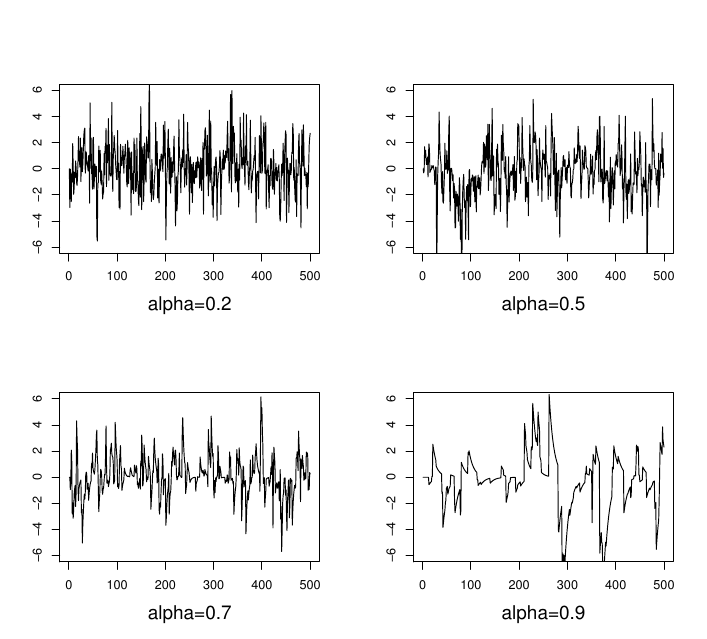
Figure 1 – Sample path of DLDAR(1) process for different values of a and θ =